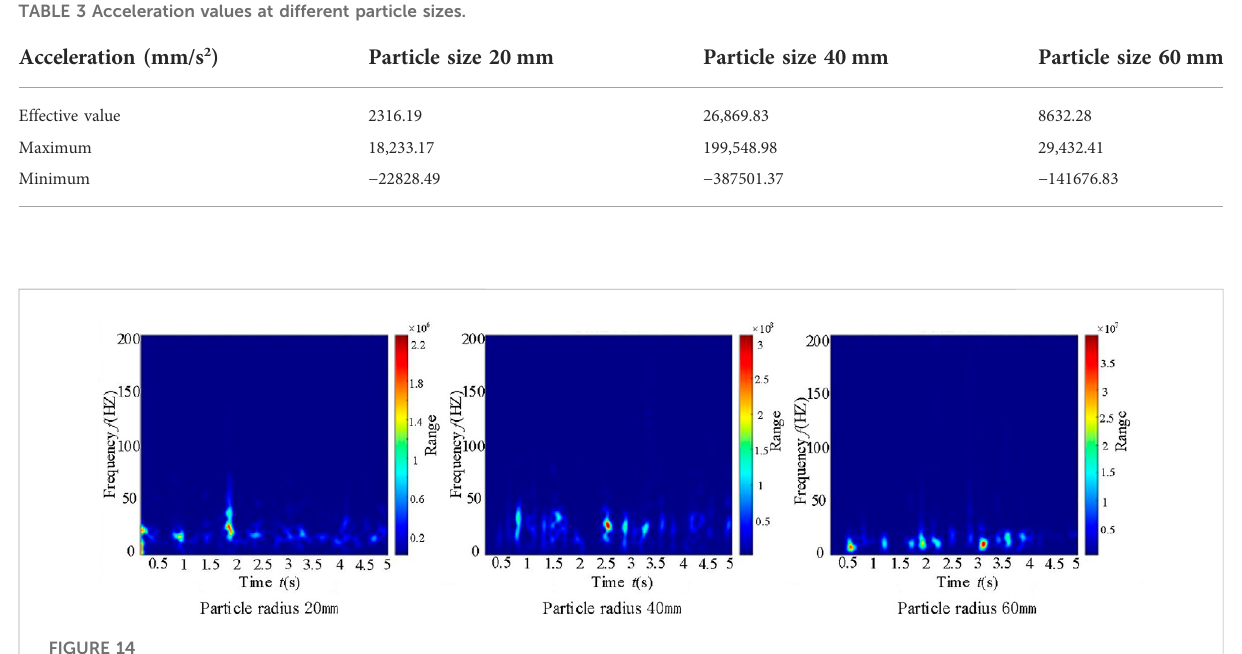
FIGURE 14 Time – frequency spectra of tail beam vibration with different particle sizes.